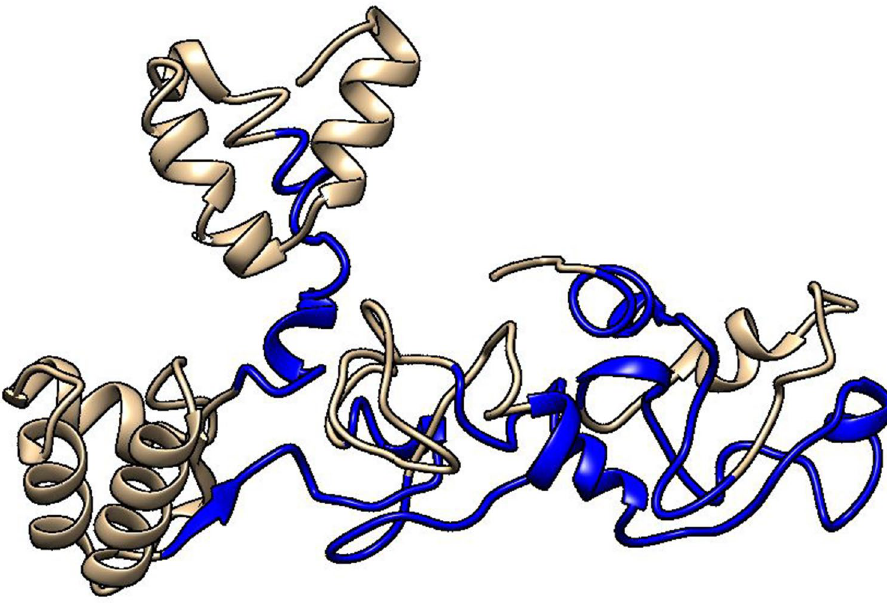
Figure 6. The linear B-cell epitopes (blue color) are highlighted in the 3D structure of the multi-epitope vaccine (tan color).